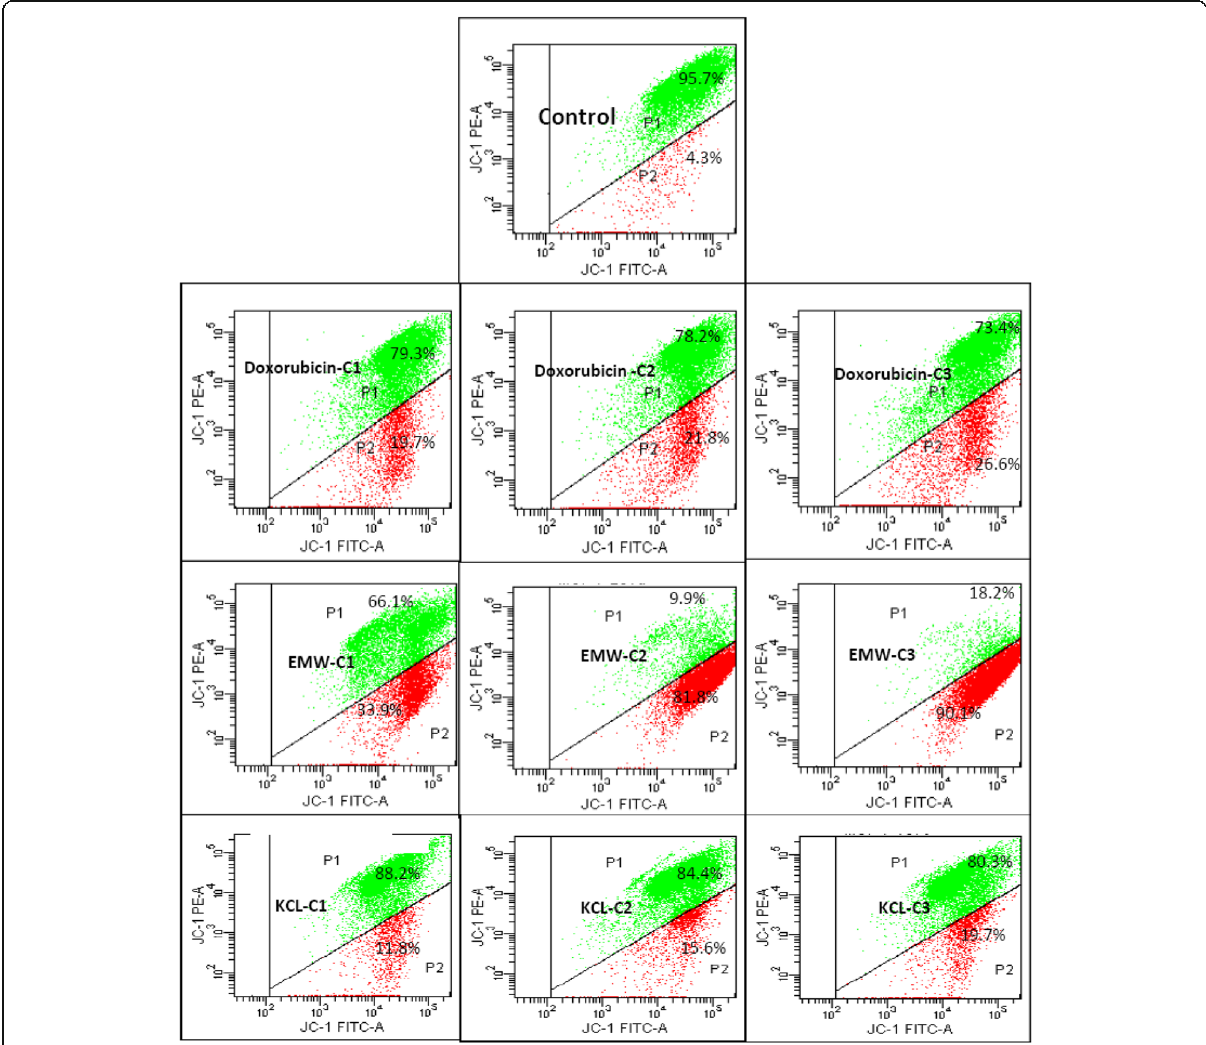
Fig. 2 Effects of Elephantopus mollis whole plant (EMW) and Kalanchoe crenata leaves (KCL) extracts and doxorubicin on MMP in MCF-7 cells for 72 h. Cells were treated with ¼ × IC 50 (C1), ½ × IC 50 (C2) and IC 50 (C3) of each compound. IC 50 values were 3.97 μ g/mL (EMW), 19.31 μ g/mL (KCL) and 0.32 μ g/mL